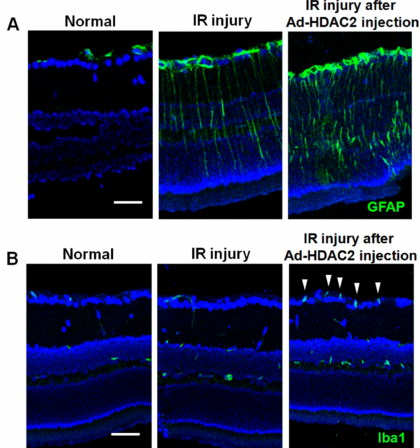
Figure 5. The e ff ect of HDAC2 overexpression on glial cell activities at 3 days after IR injury. IR injury markedly upregulated the expression of macroglial (GFAP; A ) and microglial (Iba1; B ) expression at day 3. The increased expression of Iba1 was remarkable at the ganglion cell layer and nerve fiber layer (white arrowheads). Overexpression of HDAC2 significantly exacerbates glial cell expressions in mouse retinas after IR injury. Scale bars, 50 µ m.